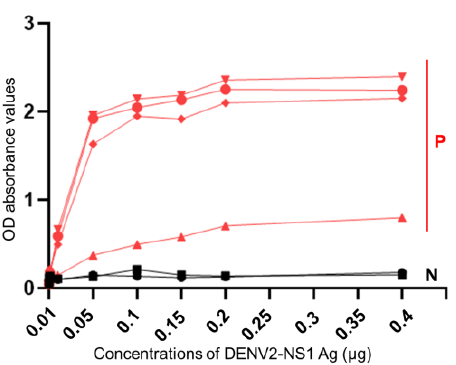
Figure 3. The detection of OD values in deferent R-DENV2-NS1 peptide concentrations of NS1 ELISA on negative and positive samples from COM ELISA. (P) are positive samples, whereas (N) are negative samples.